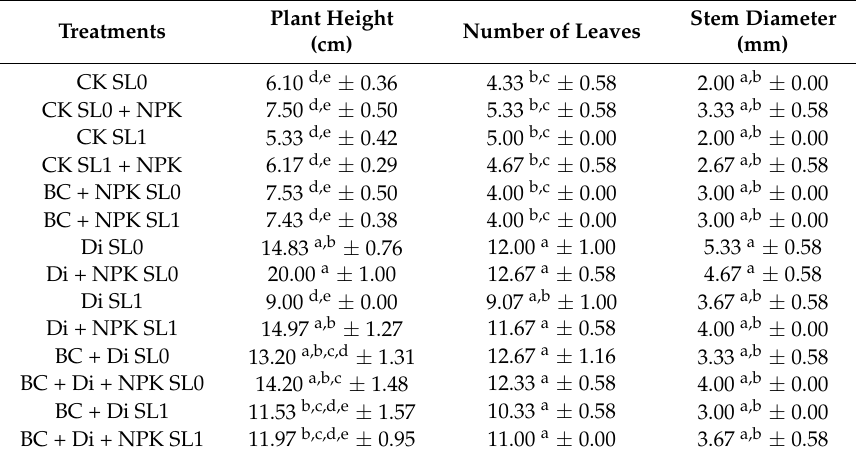
Figure 2. Effect of biochar and digestate treatments on Chinese melon photosynthesis rate ( a ) Vegetative growth; ( b ) Flowering stage and ( c ) Fruit stage under normal water (SL0) and saline water (SL1) treatments. Table 5. Mean (± Standard deviation) growth parameters of melon plants at the vegetative growth stage.